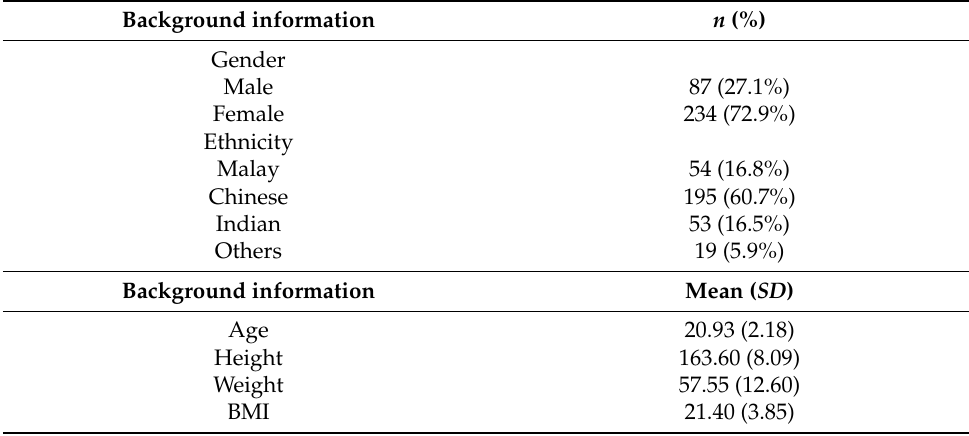
Table 1. Demographic profile of participants ( N =